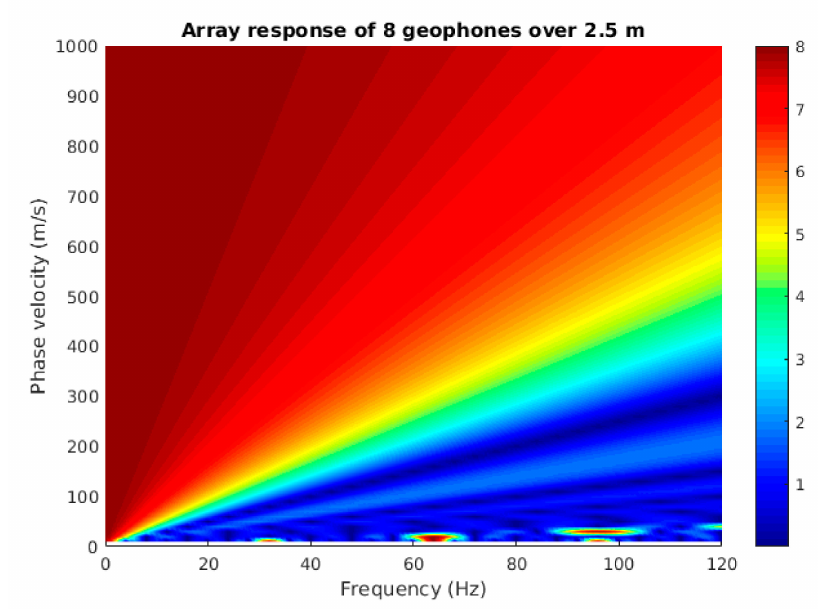
Figure 5. The array response of geophone strings with eight geophones where the length and group intervals are 2.5 m. The colors represent the gain of using the array relative to using a single geophone. Using geophone groups significantly downgrades the quality of the surface wave data at high frequencies, but a ff ects in a minor way the amplitudes at low frequencies, except for at very low phase